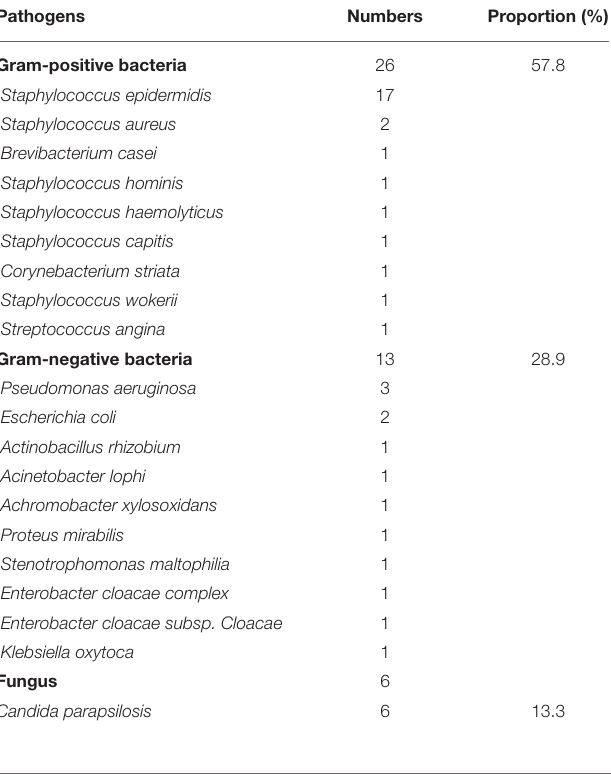
TABLE 2 | Distribution of positive pathogens.